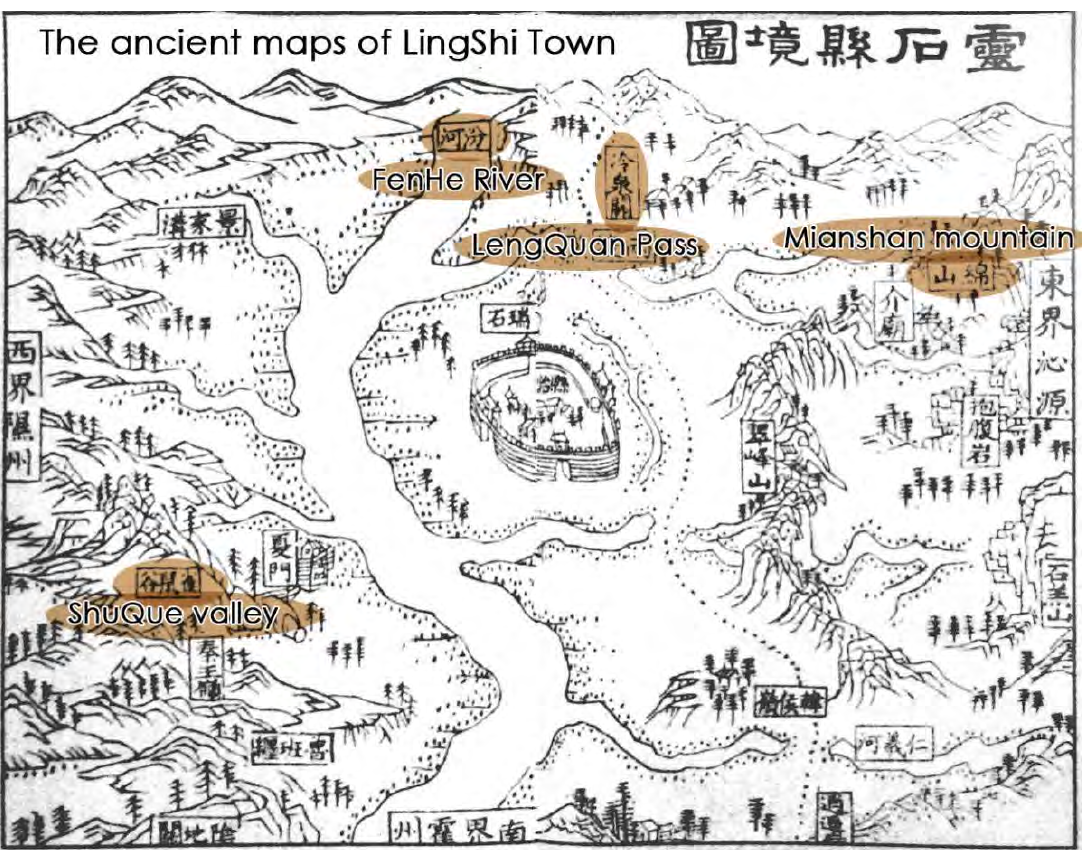
Figure 3 LengQuan village’s ancient